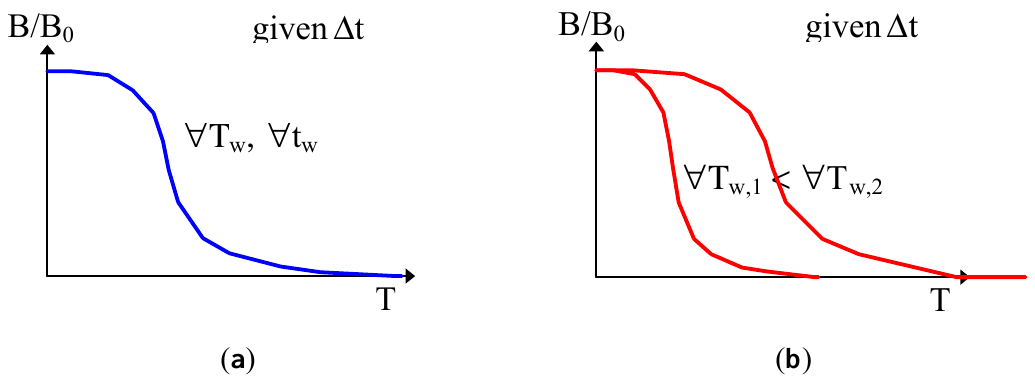
Figure 19. Isochrons curves. ( a ) SIREPA; ( b ) VAREPA.